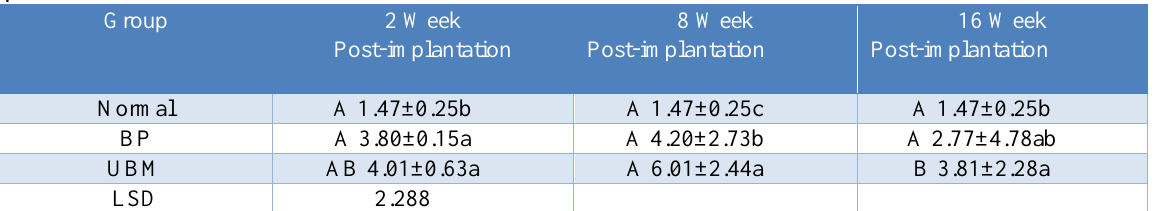
Table,5: The means ±SE values of b-FGF in Control, BP and UBM groups at different period